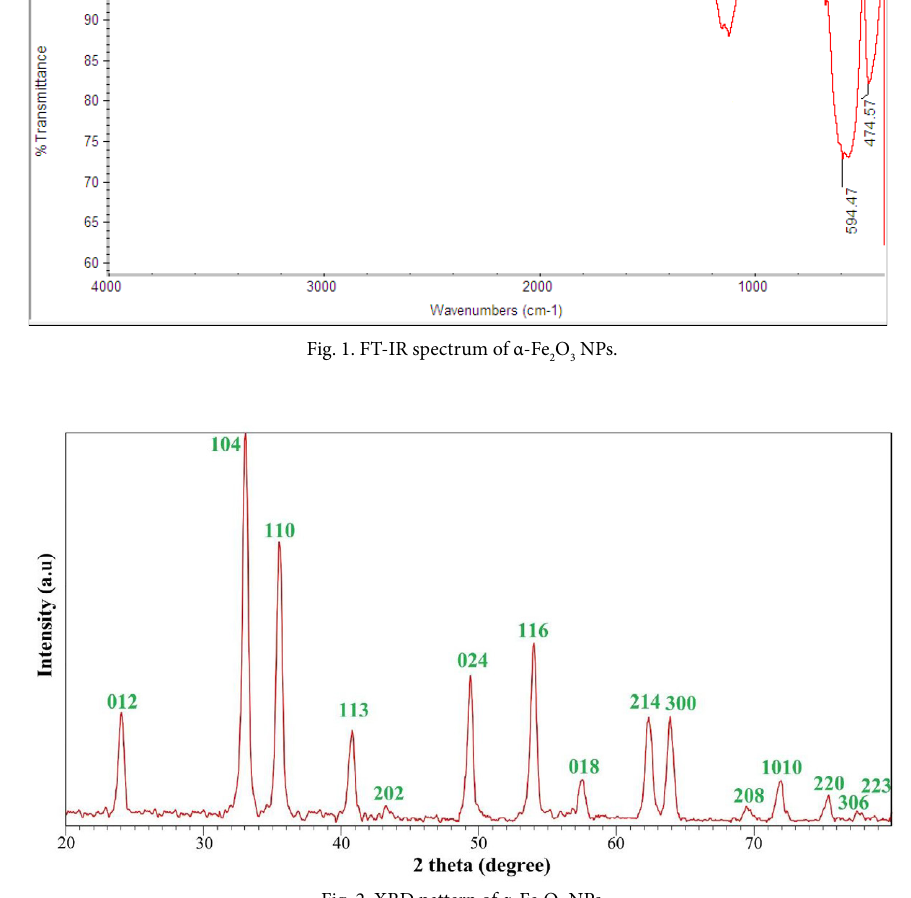
Fig. 2. XRD pattern of α -Fe 2 O 3 NPs.